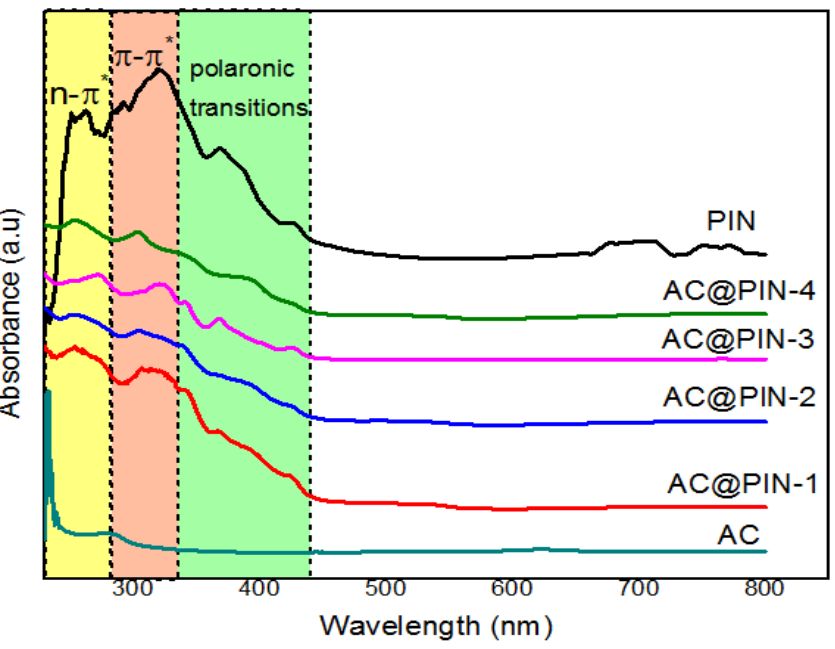
Figure 5. UV-Vis spectra of PIN, AC, and AC@PIN composites.